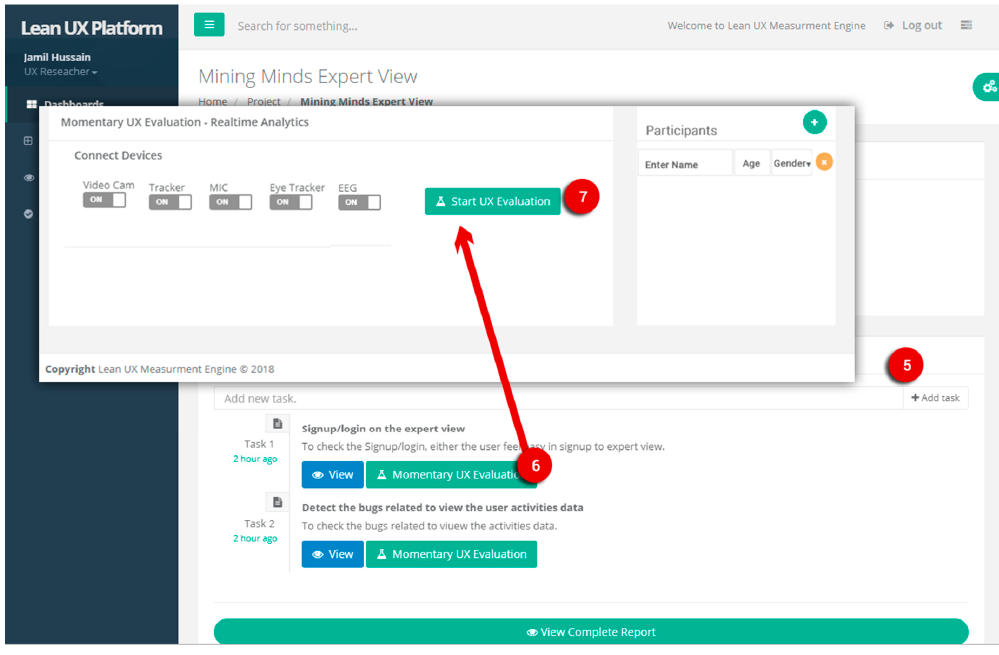
Figure A3 . Task creation and evaluation process by task wise.